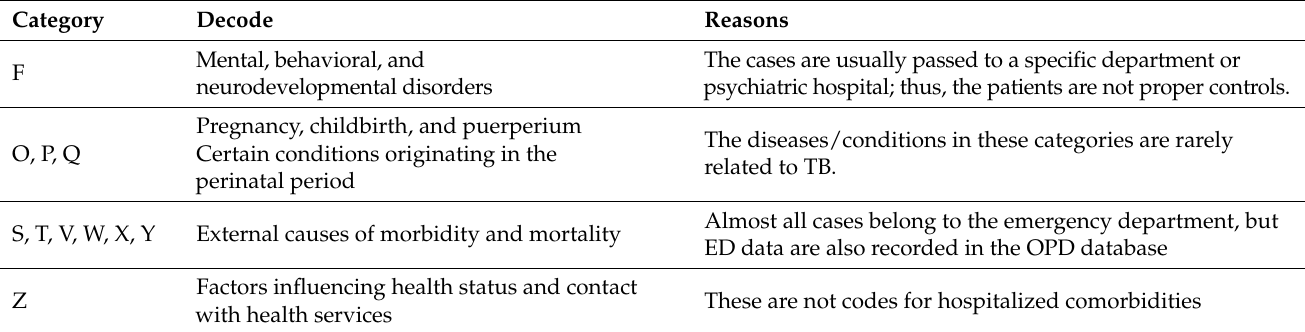
Table 1. Categories for the exclusion of irrelevant